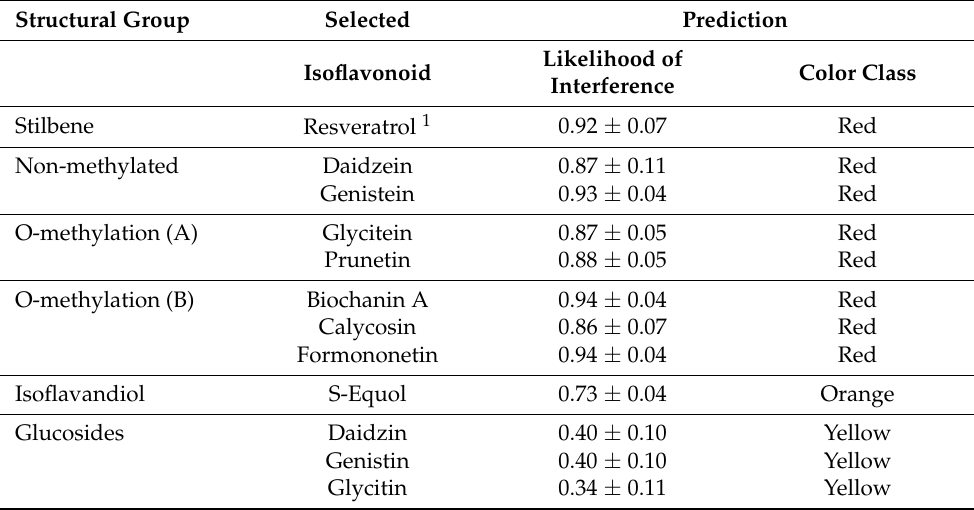
Table 1. Results of the InterPred predicted interference with firefly luciferase for the positive control (resveratrol) and the 11 selected isoflavonoids, according to their structural grouping (Figure 1). The predicted likelihood of interference is expressed from 0 to 1 (closer to 1, higher likelihood of interference), with color-coding also shown (see Methods). Structural Group Selected Prediction Likelihood of Color Class Isoflavonoid Interference Stilbene Resveratrol 1 Non-methylated